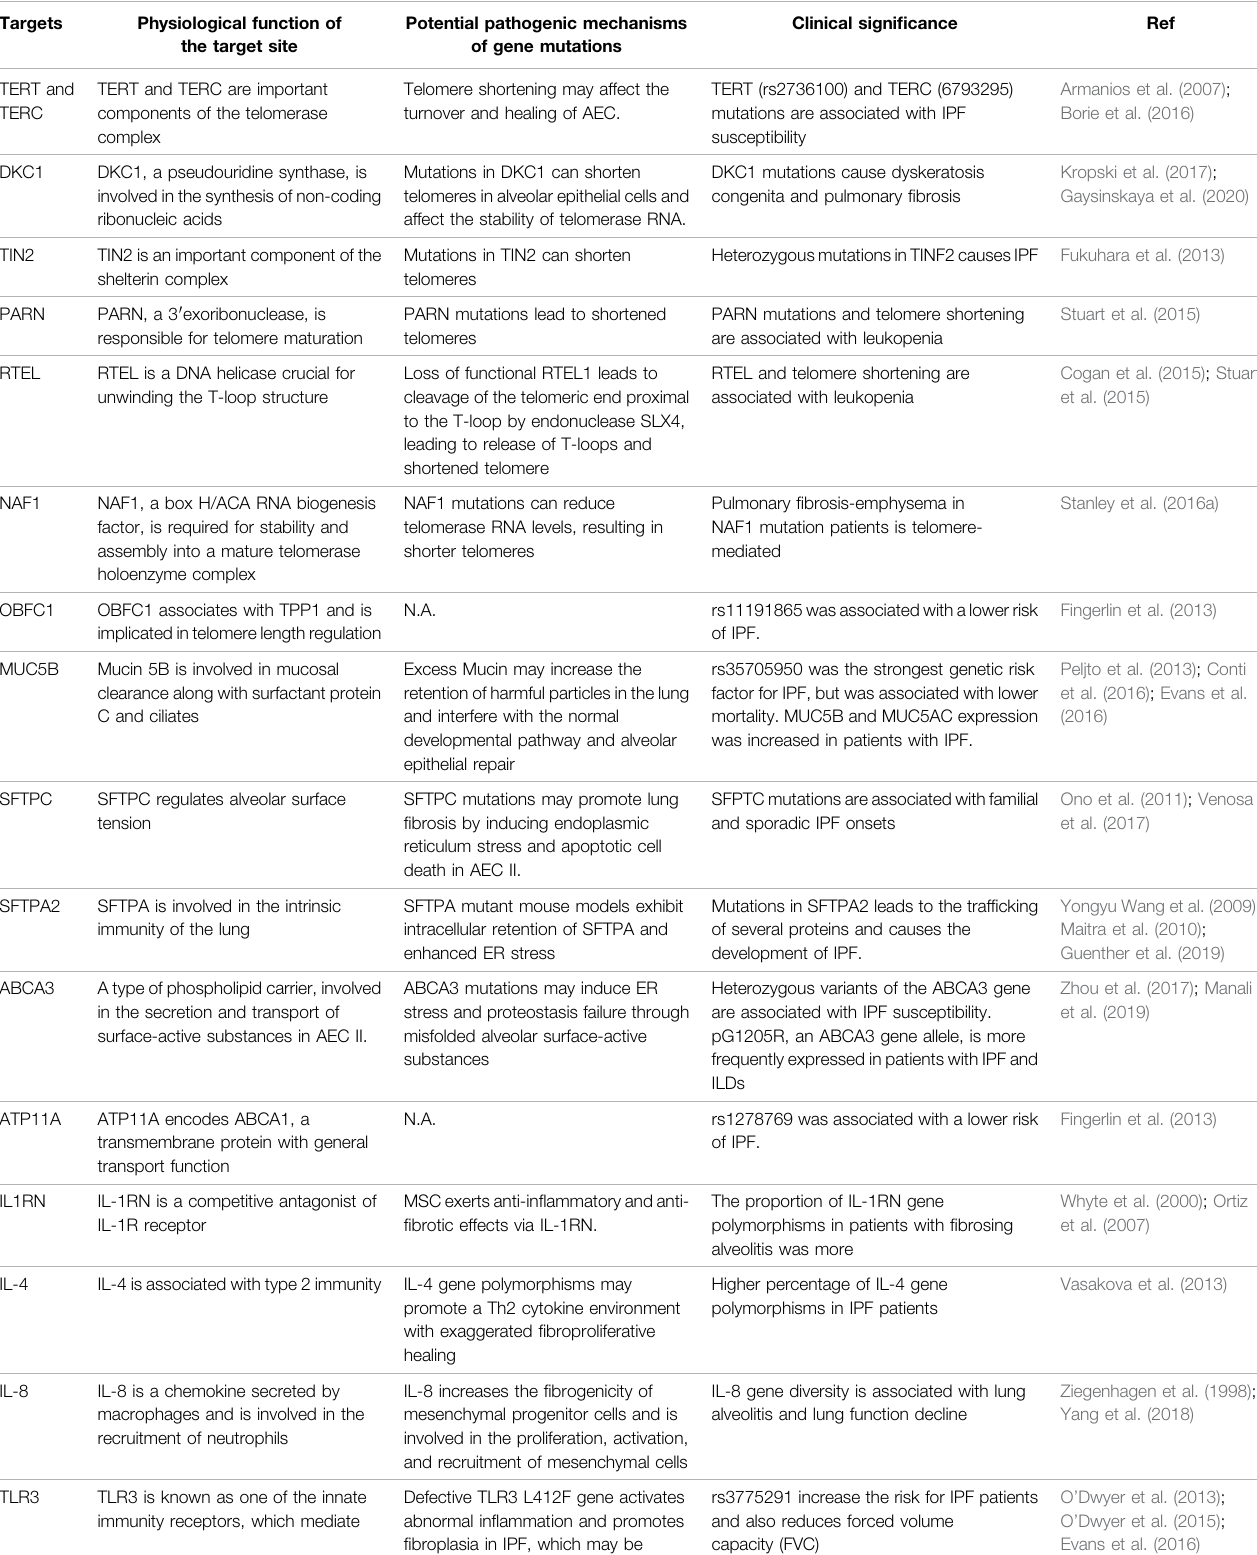
TABLE 2 | Genetic mutations associated with